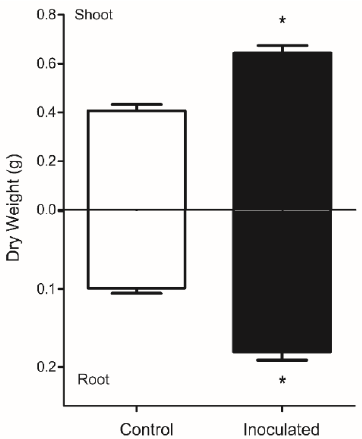
Figure 1. E ff ect of inoculation of endophytic strain Chaetomium cupreum on shoot and root dry weight of Eucalyptus globulus (90 days post-inoculation). Values are expressed as means ± standard error. Statistical significance was evaluated with t -student test *( p ≤ 0.05). Microorganisms 2019 , 7 , x FOR PEER REVIEW